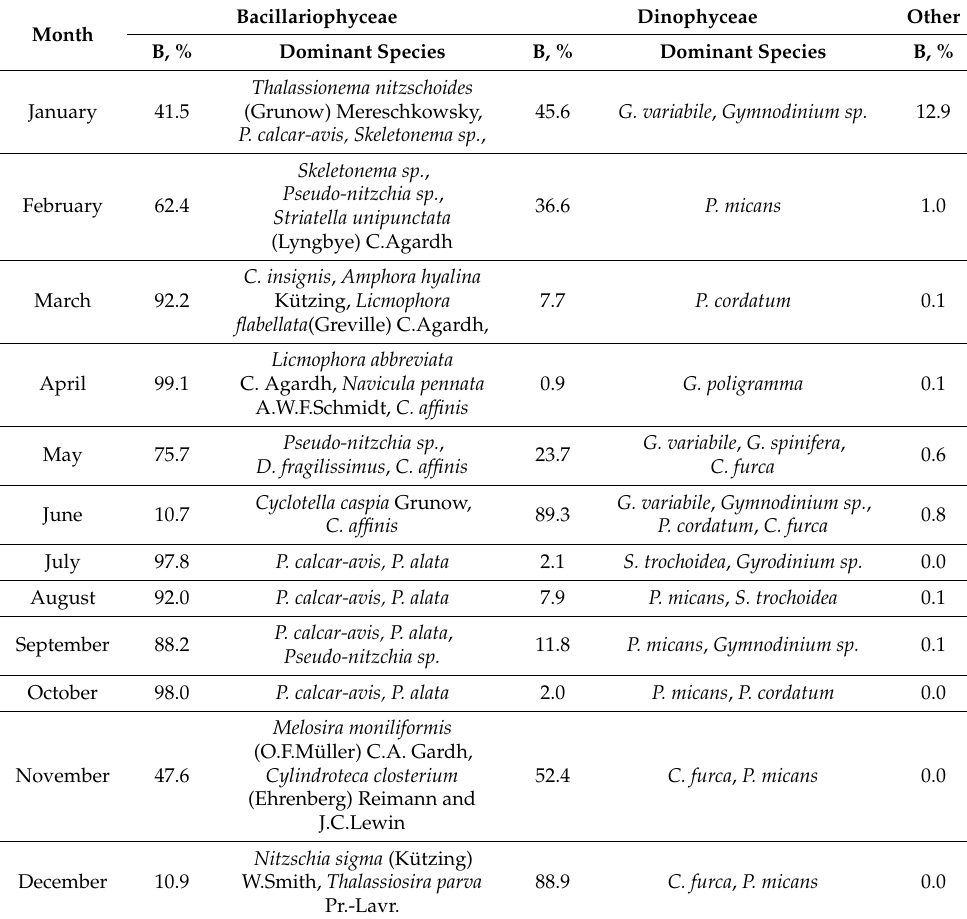
Table 3. Relative biomass (B) and dominant species of diatoms (Bacillariophyceae) and dinoflagellates (Dinophyceae) in the phytoplankton of Station 3 in